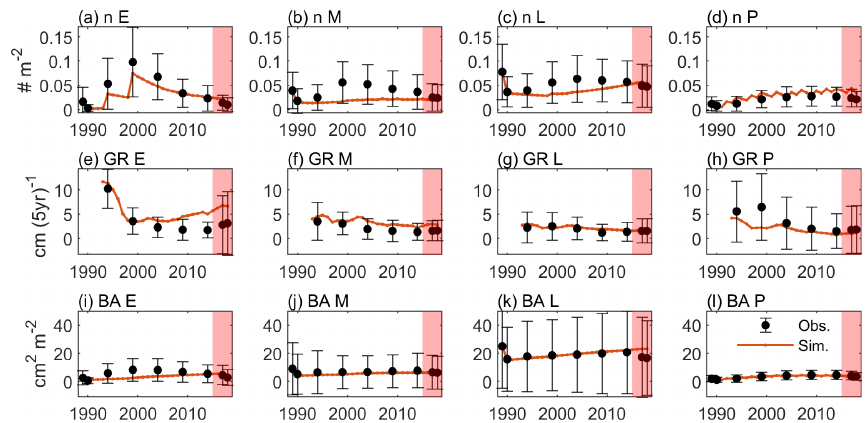
Figure 4. Time series of variables from observation (dots and error bars) and the optimal simulation (red lines). (a–d) Stem density of all trees ( n ; DBH ≥ 2 . 5cm) (individualsm − 2 ) for Early, Mid, Late, and Palm PFTs, respectively. (e–h) Diameter growth rate (GR; cm(5yr) − 1 ) for the four PFTs. (i–l) Basal area (BA; cm 2 m − 2 ) for the four PFTs. The dots and the error bars represent the means and 1 standard deviation from the means across the 85 plots. Period between 1989–2014 is for model calibration and period between 2015–2018 is for model validation (shaded).